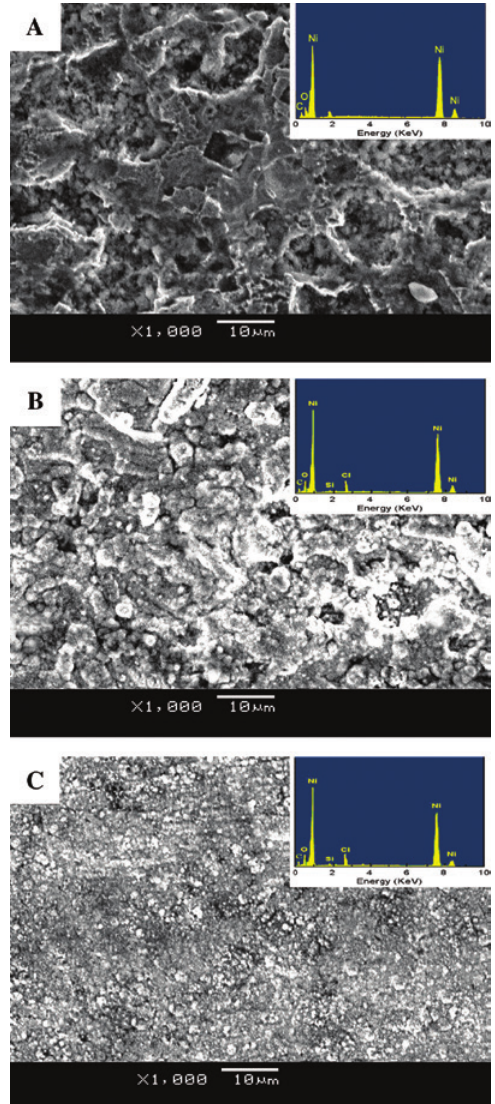
Figure 7 SEM images of samples after corrosion test: (A) DC, (B) PC, and (C) UAPC.